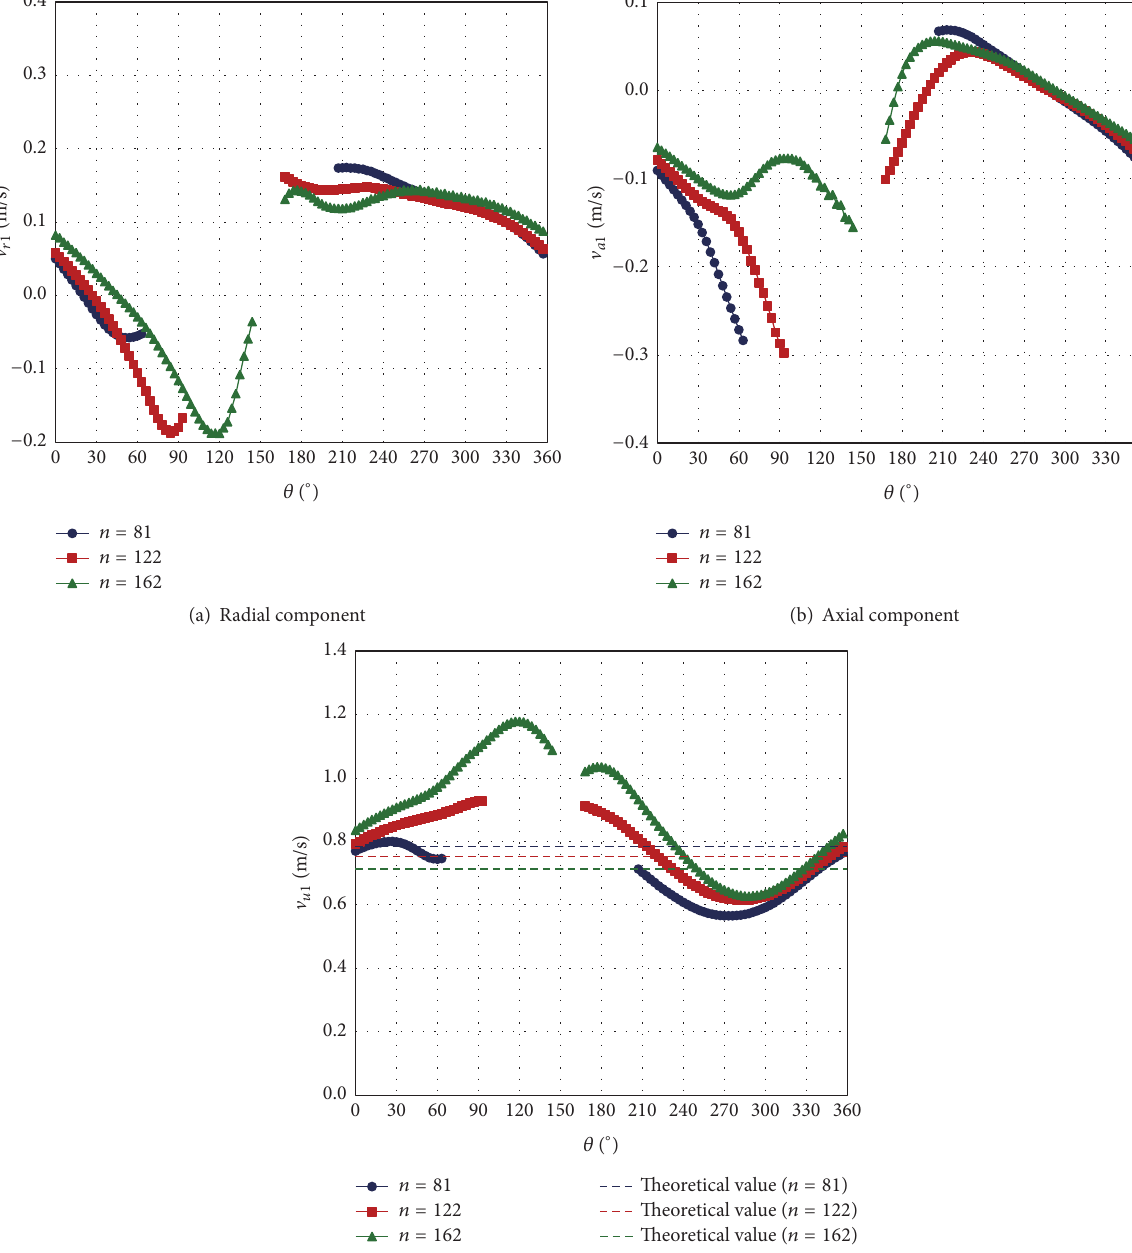
Figure 12: Absolute velocity at runner inlet (Cal.).